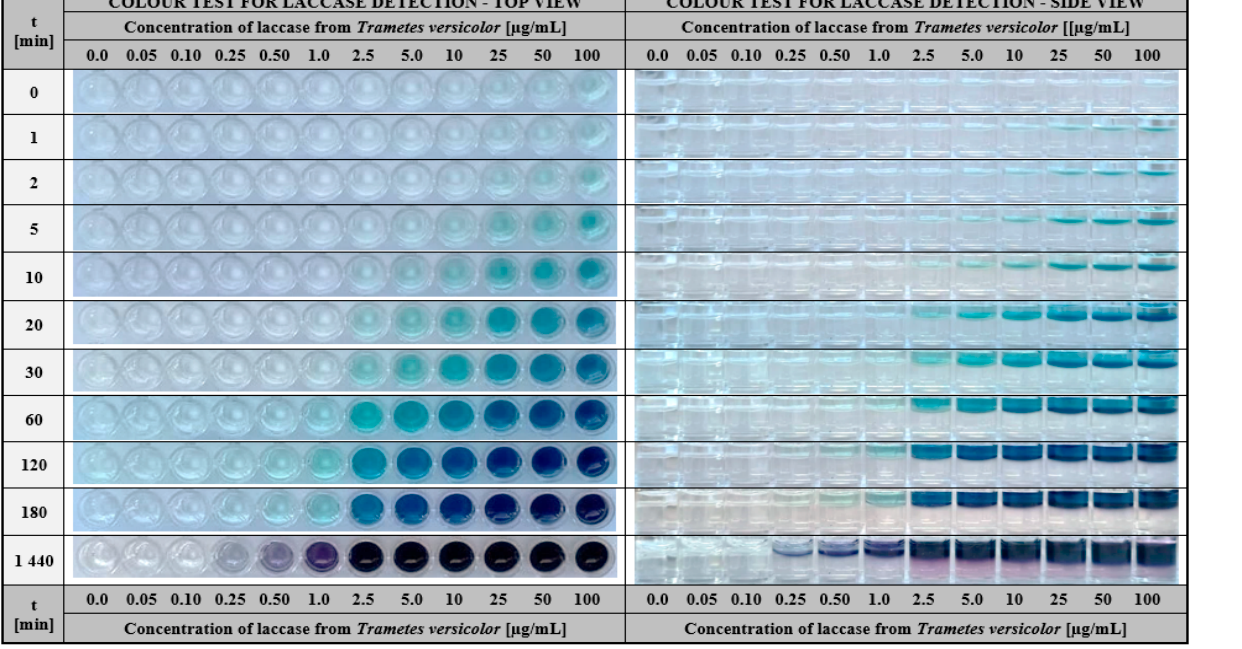
Figure 3. The visual response obtained after a different time (0–1440 min) of hydrogel-based test with immobilised 1.5 mg/mL ABTS performed for laccase from Trametes versicolor solutions with a concentration range of 0.05–100 µg/mL, left—top view, right—side view. As early as 5 min after the samples were applied, a distinct change in the gel colour was observed for laccase in the concentration between 10 and 100 µg/mL (Figure 3, side view). Prolonging the assay time to at least 20 min increased the sensitivity of the test which enabled the detection of the laccase concentration even at 2.5 µg/mL. Further ex- tension of the time to 120 min resulted in a colour response in the ABTS test for two suc- cessively lower concentrations of this enzyme (1.0 and 0.5 µg/mL). Moreover, the results